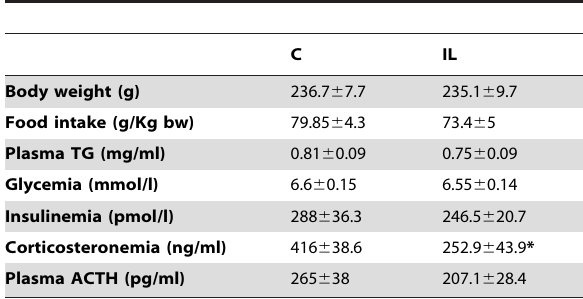
Table 1. Basal characteristics of the experimental groups after 24 h of carotid infusion.